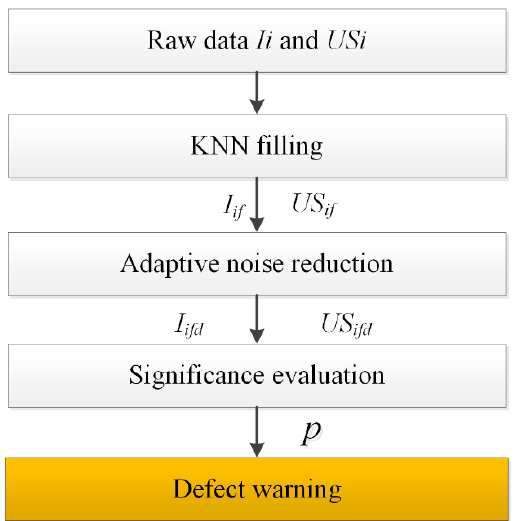
Figure 2. Flow chart of the combined acoustic and electric diagnosis algorithm for reactors.